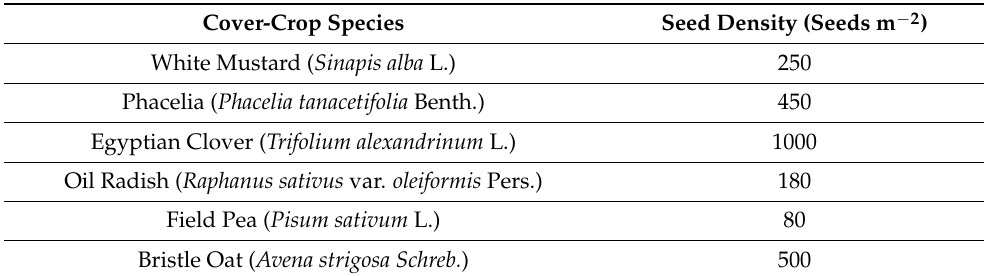
Table 1. List of cover-crop species and seed densities for pure stands. Cover-crop Species